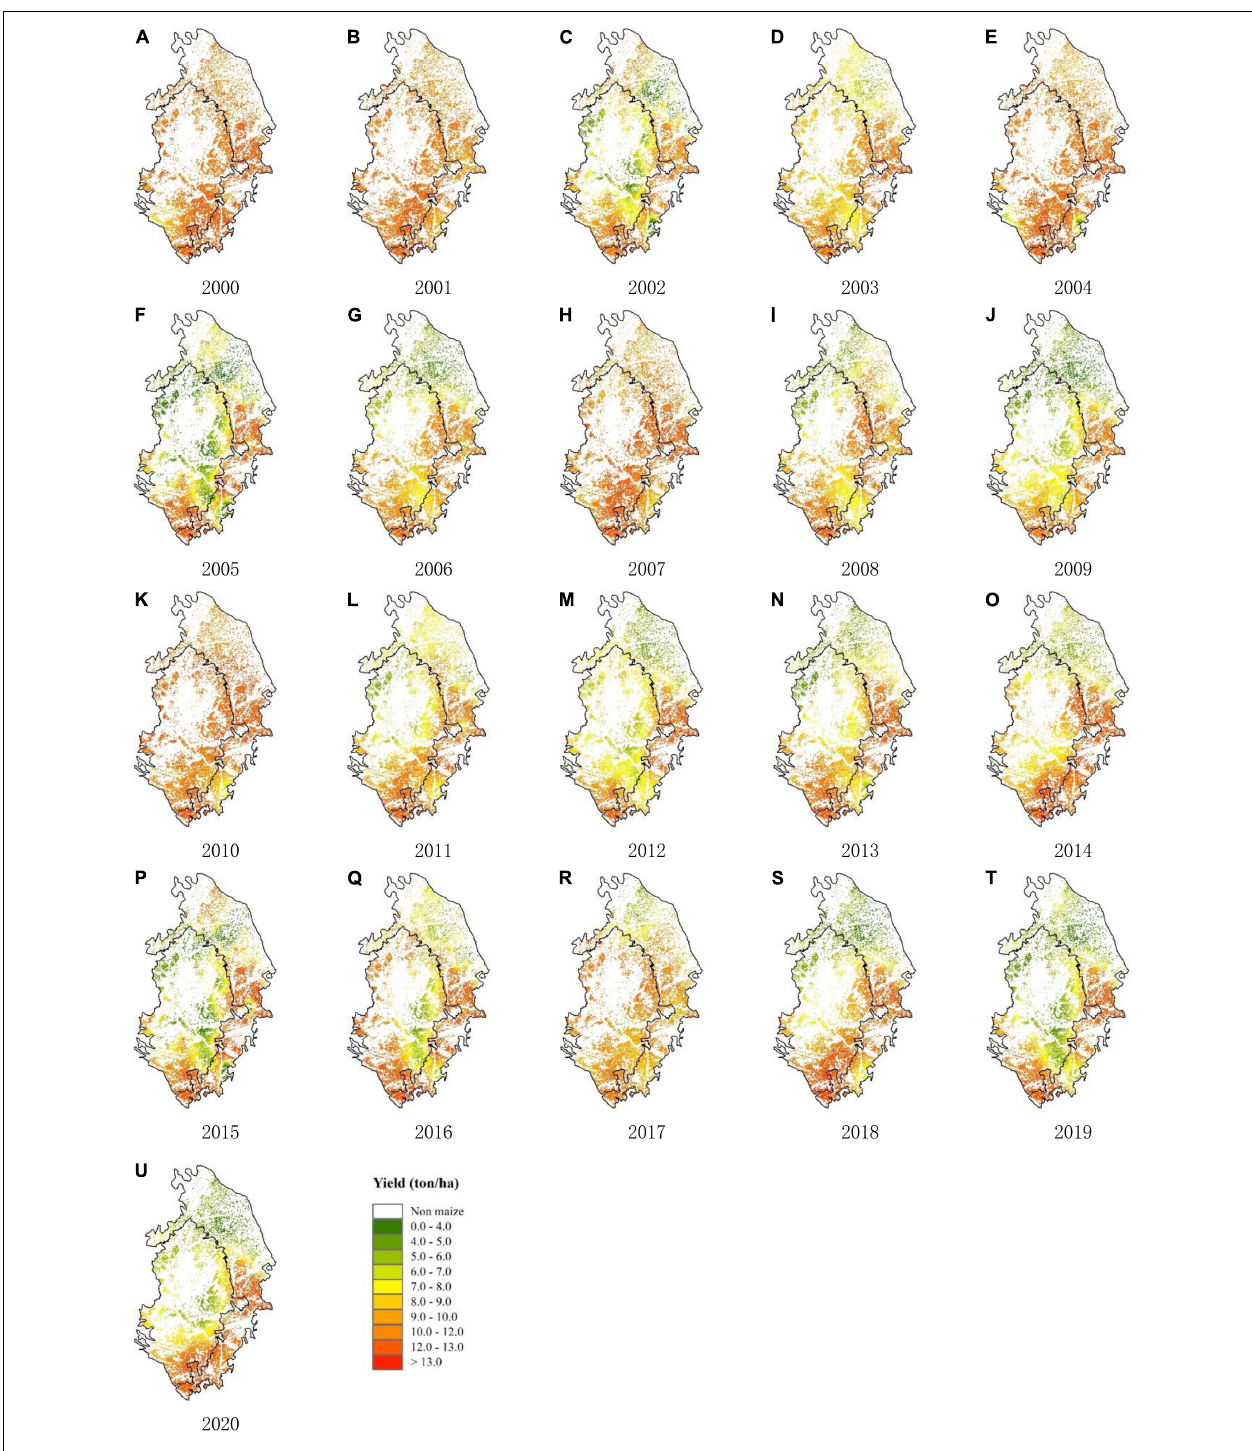
FIGURE 6 | Maize yield map (ton/ha) for Songnen Plain simulated by AquaCrop model from 2000–2020.